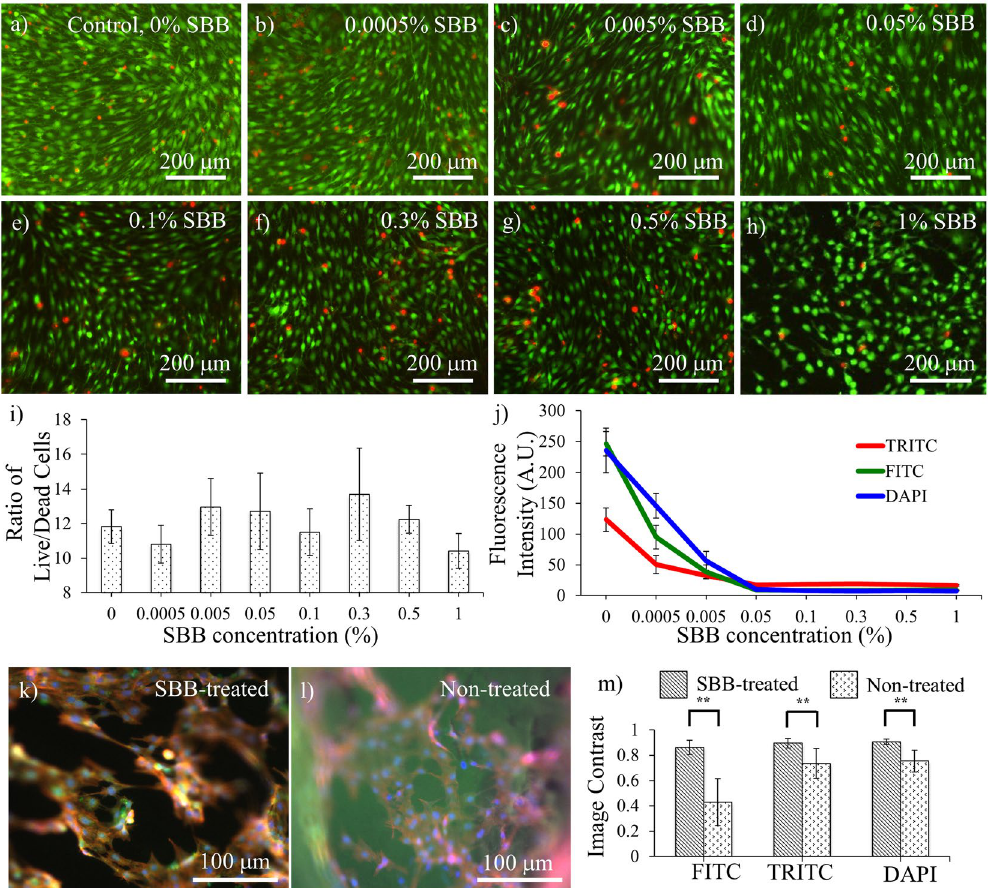
Figure 2. The changes of cell viability and autofluorescence suppression with the SBB concentration. ( a – h ) Fluorescence images showing live and dead cells of 3T3 fibroblasts on PCL slabs with different SBB concentrations. Scale bar = 200 μ m. ( i ) The change of the ratio of live/dead cells with the SBB concentration. No significant difference was found among the groups with different SBB concentrations (p > 0.05). ( j ) The fluorescence intensity of the autofluorescence of PCL slabs treated with 0% to 1% SBB concentrations. ( k and l ) The representative fluorescence images of the PCL slabs cultured with 3T3 fibroblasts: ( k ) with 0.3% SBB and ( l ) non-treated. ( m ) The image contrasts of the fluorescence images of the PCL slabs cultured with 3T3 fibroblasts. For ( a )–( h ), the cells were stained by live/dead assay on Day 3 of cell culturing. Green denotes live cells; red denotes dead cells. For ( k ) and ( l ), the cells were stained by calcein AM, rhodamine-phalloidin, and DAPI on Day 3. Green denotes cytoplasm; red denotes F-actins; and blue denotes cell